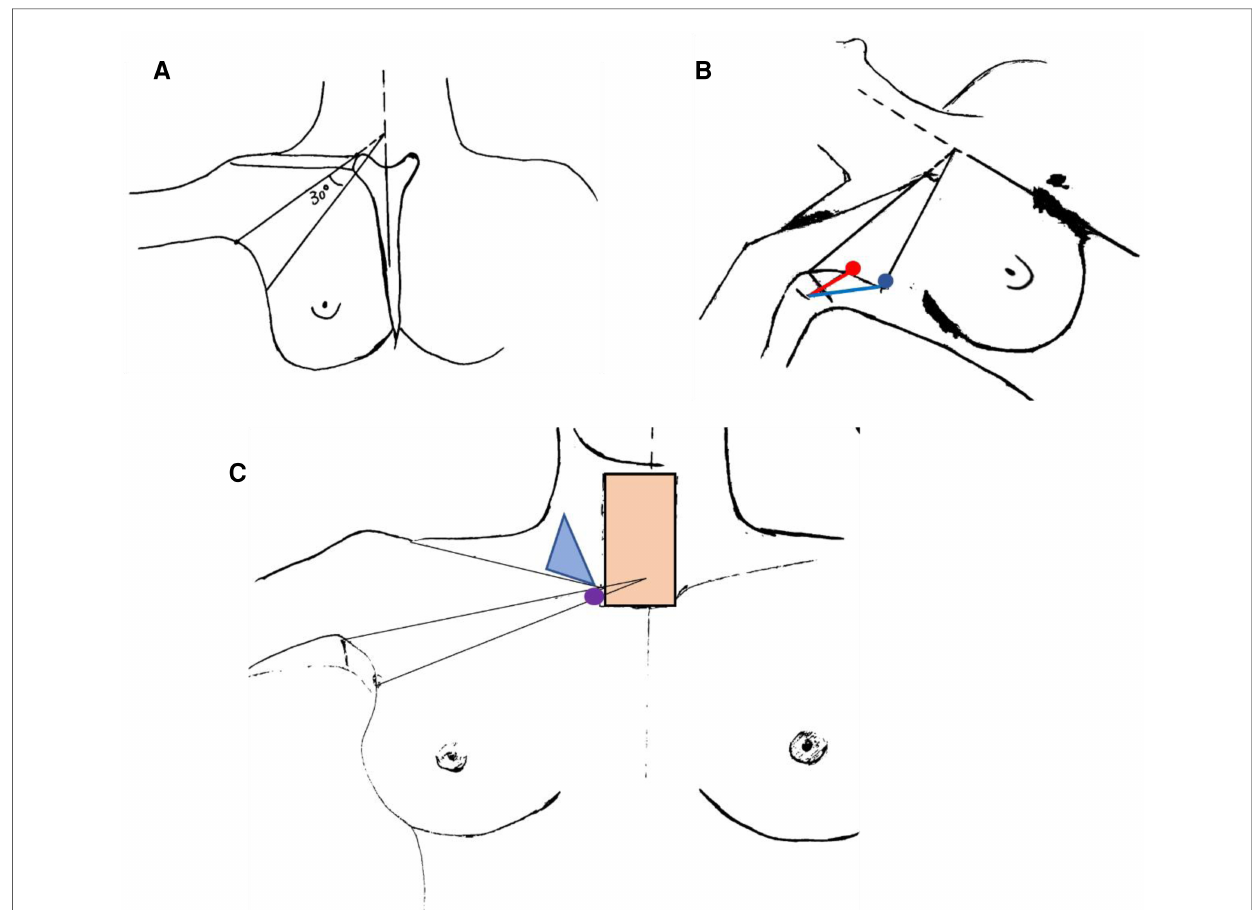
FIGURE 3 Schematic diagrams of zero-line and classical incision design. ( A ) Schematic diagram of zero-line incision design. ( B ) Comparative diagram of the two designs representing different positions of trocar incision. The red dot and line indicated the classical trocar incision and the distance to the main incision, and the blue dot and line indicated the zero-line ones. ( C ) Diagram representing the lever principle of zero-line incision design. The purple dot indicated the fulcrum (clavicular head of sternocleidomastoid). The light blue triangle indicated the supraclavicular fossa. The meat-colored square indicated the surgical lesion of